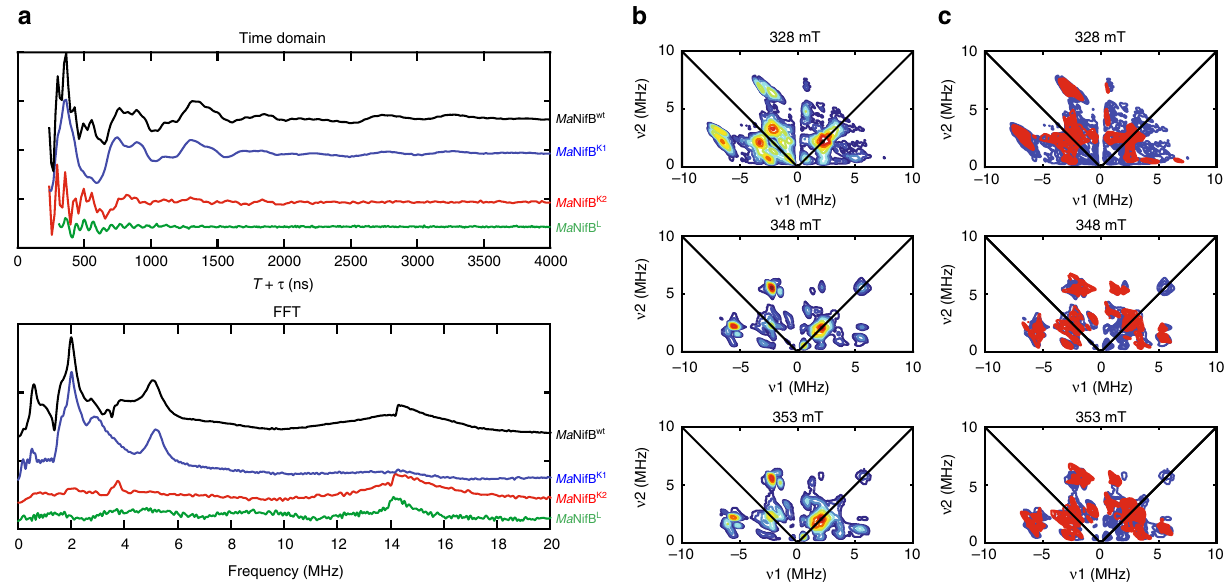
Fig. 2 Pulse EPR analysis of Ma NifB. a Three-pulse ESEEM spectra of dithionite-reduced Ma NifB wt (black), Ma NifB K1 (blue), Ma NifB K2 (red), and Ma NifB L (green). The time domain spectra of Ma NifB wt and Ma NifB K1 have modulations from 14 N that appear as peaks in the fast Fourier transformed (FFT) spectra between 1 and 8 MHz. The sharp modulations between 250 and 500 ns in the time domain and the resulting broad peak near 14 MHz in the FFT are from nearby weakly coupled protons. b HYSCORE spectra of the dithionite-reduced Ma NifB K1 taken at 328, 348, and 353 mT. c The HYSCORE data (blue) can be simulated (red) with a single 14 N nucleus, with a hyper fi ne coupling tensor A (in MHz) = [2.9 2.9 5.6] and a quadrupole coupling of e 2 Qq / h = − 2.1 MHz and η = 0.4. Three-pulse ESEEM spectra were recorded at 10 K, τ = 128 – 144 ns (values chosen to minimize proton modulations to the spectra), π /2 = 12 ns, and a microwave frequency of 9.3366 GHz ( Ma NifB wt , Ma NifB K1 , Ma NifB K2 ) or 9.2465 GHz ( Ma NifB L ). Spectra were collected near the g 2 value (spectra maxima) for each of the samples ( Ma NifB wt : 343 mT; Ma NifB K1 : 343 mT, and Ma NifB K2 : 344 mT, and Ma NifB L : 340 mT). Ma NifB K1 HYSCORE spectra were recorded at 10 K, τ = 128 – 132 ns, and π /2 = 12